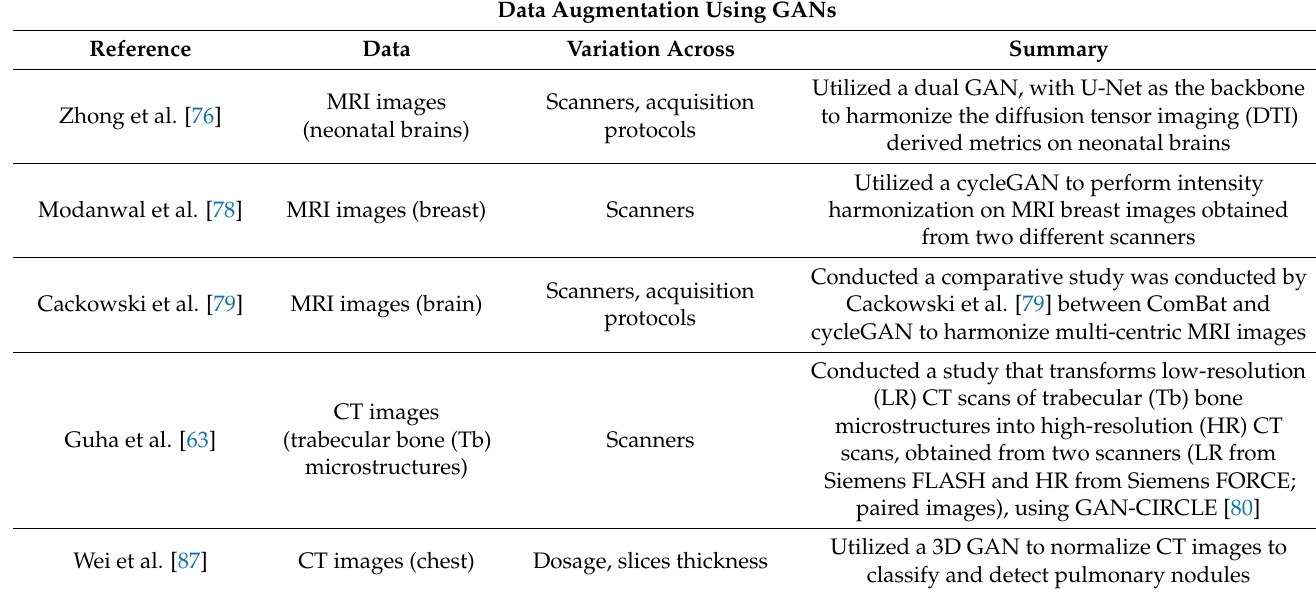
Figure 4. Normalization results reused from [87] with original copy obtained from authors. The row represents a sagittal view of the scans containing the ROI nodule. Column ( a ) represents the target image; Column ( b , e , h ) shows the input images with different slice thicknesses and dosage; Columns ( c , f , i ) show the CNN results and Columns ( d , g , j ) show the GAN-based results.